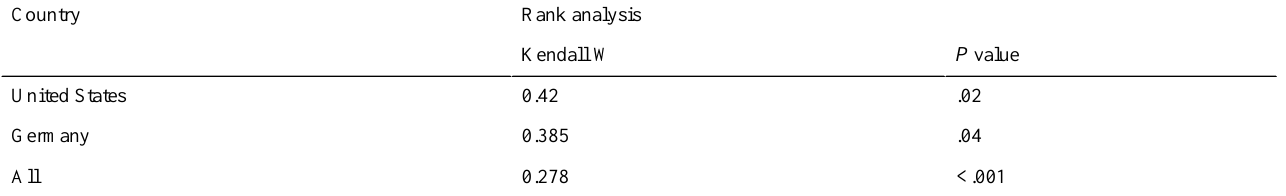
Table 2. Regional concordance across